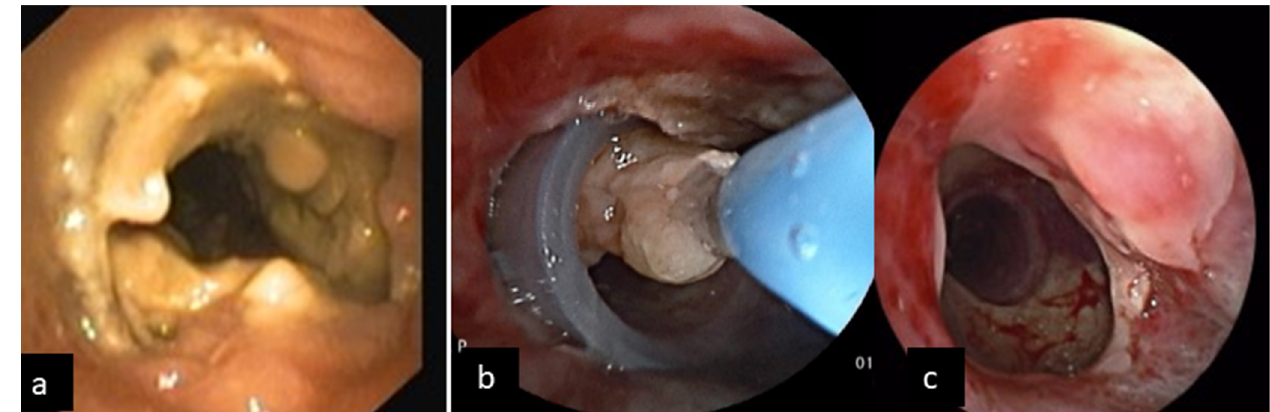
Figure 3. Bronchoscopic view of complicated tracheal stents with obstruction due to biofilm and thick purulent mucous accumulation ( a ), removal of sticky secretions making use of cryoprobe ( b ) and peripheral stent migration ( c ).